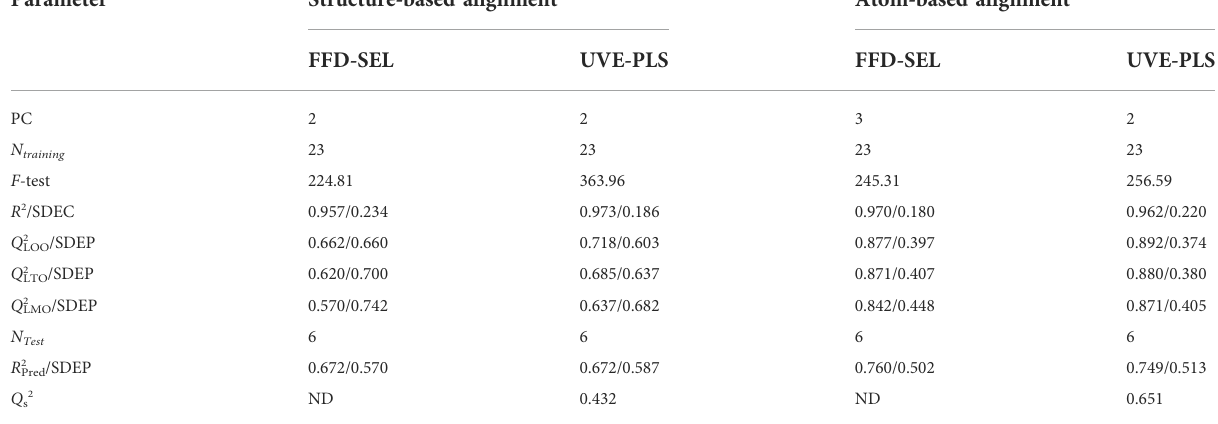
TABLE 3 Statistical results of 3D-QSAR